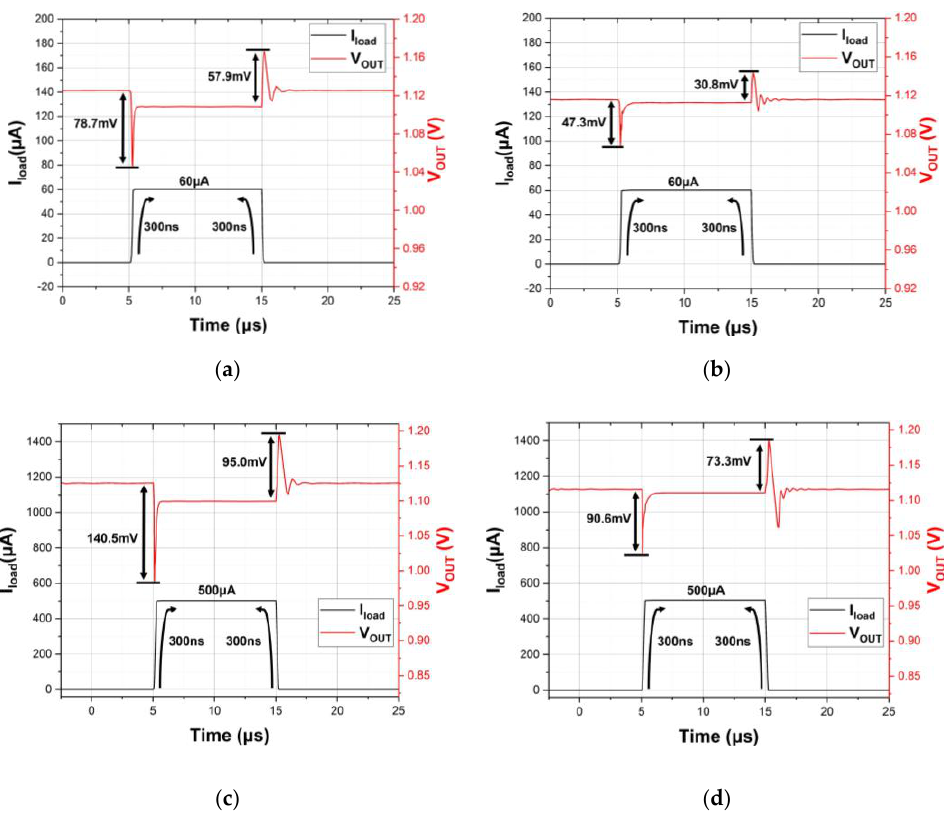
Figure 17. Transient response with 60 μ A current pulse of ( a ) conventional design; ( b ) proposed work; and with 500 μ A current pulse of ( c ) conventional design; ( d ) proposed work.